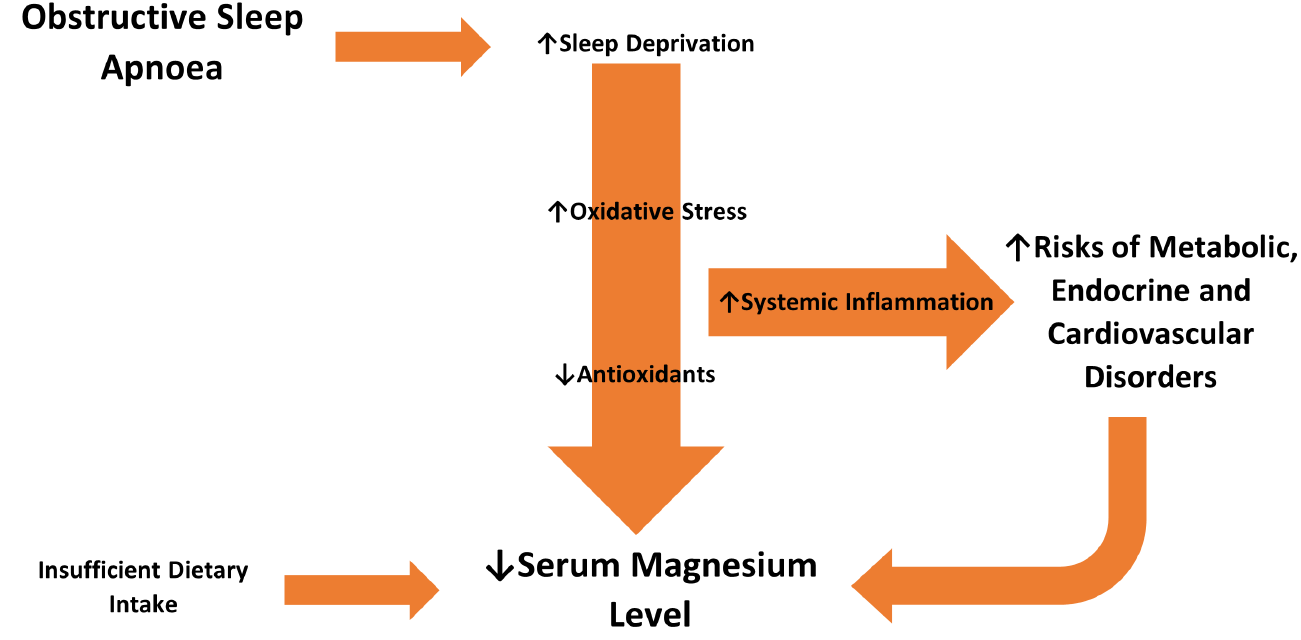
Figure 5. Hypothesis: OSA as a causative factor in lowering serum Mg